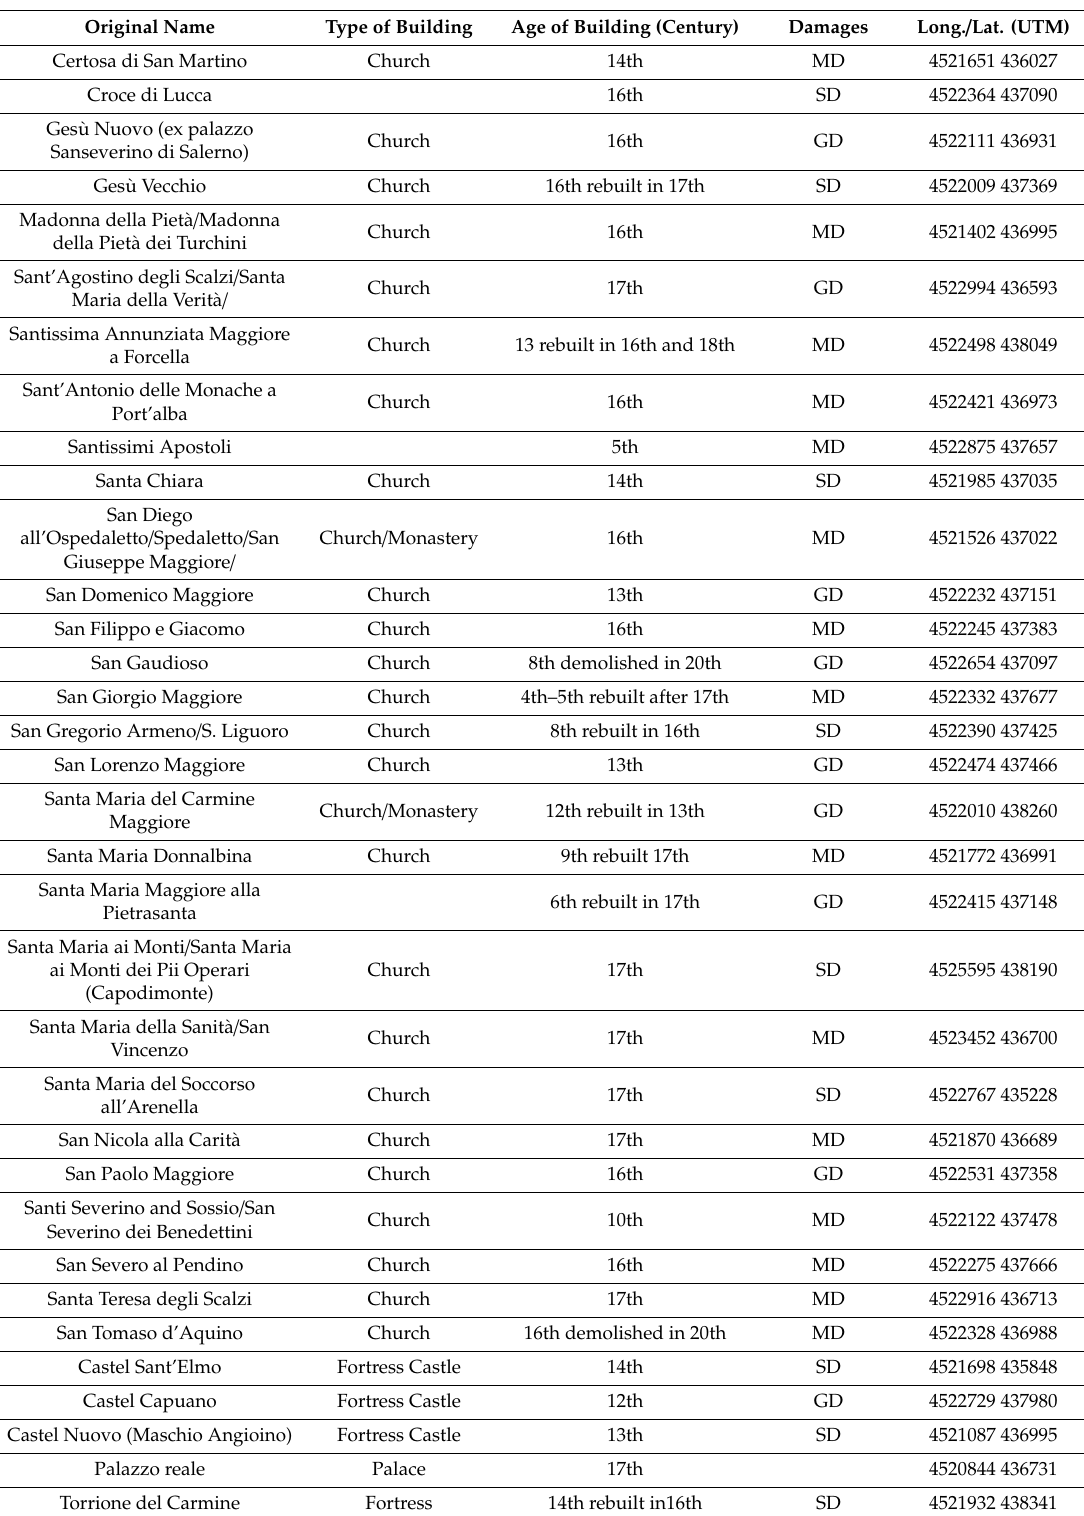
Table A3. The historical buildings of Naples damaged by the 1688 earthquake [5–7,14]; MD = Minor Damage; SD = Serious Damage; GD = Great